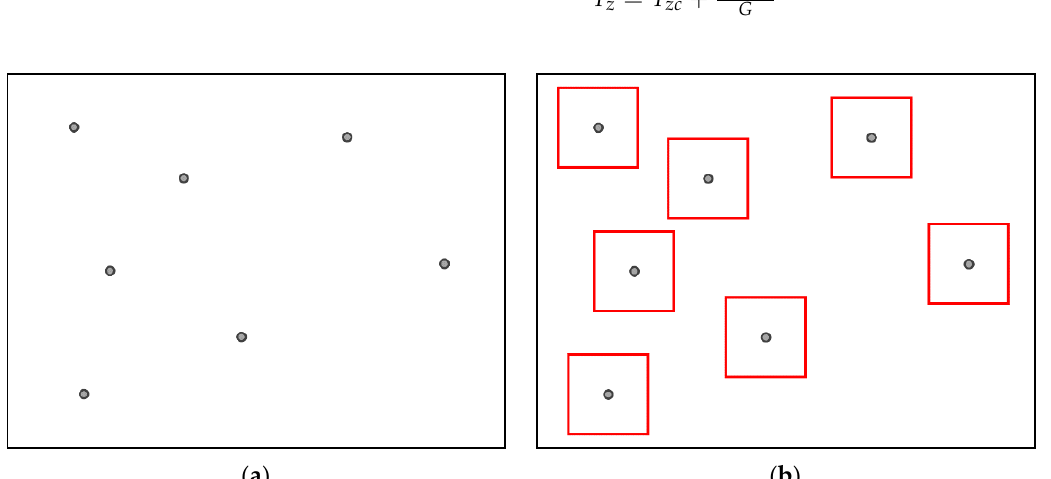
Figure 2. ( a ) Spatial layout of the data items; ( b ) neighborhood ranges for the individual data items.